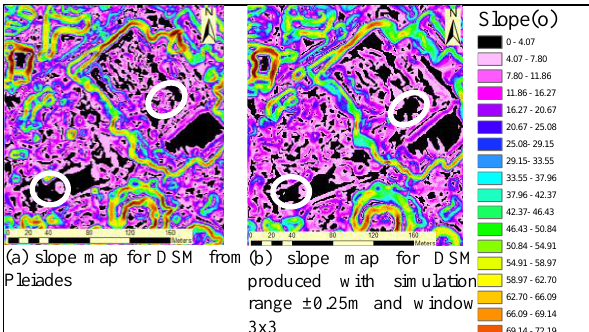
Figure 8. Slope map analysis for merged DSMs, the white symbolization shows the effect of merging on removing the slope.